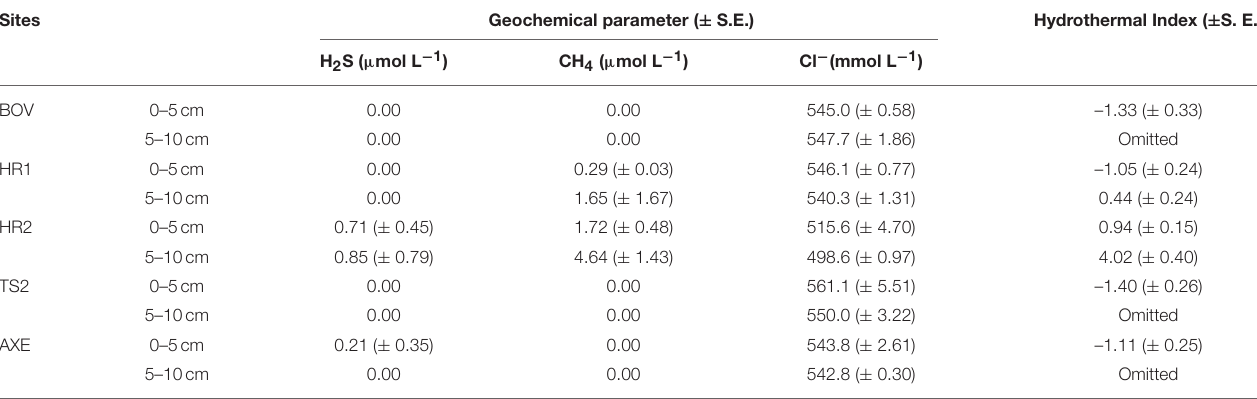
TABLE 3 | Mean concentrations of four geochemical parameters (binned into upper and lower partitions) used to calculate the hydrothermal index (Data from Aquilina et al., 2013, 2014). Sites